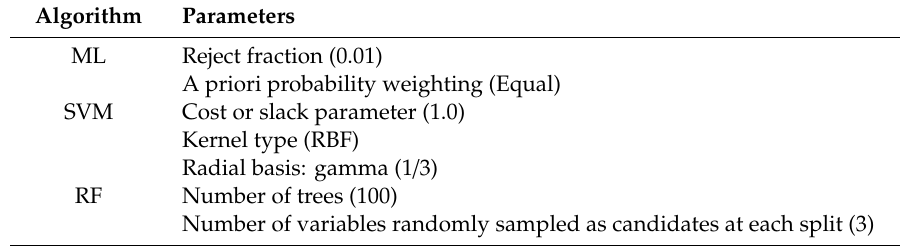
Table 1. Parameters of Maximum Likelihood (ML), Support Vector Machine (SVM), and Random Forest